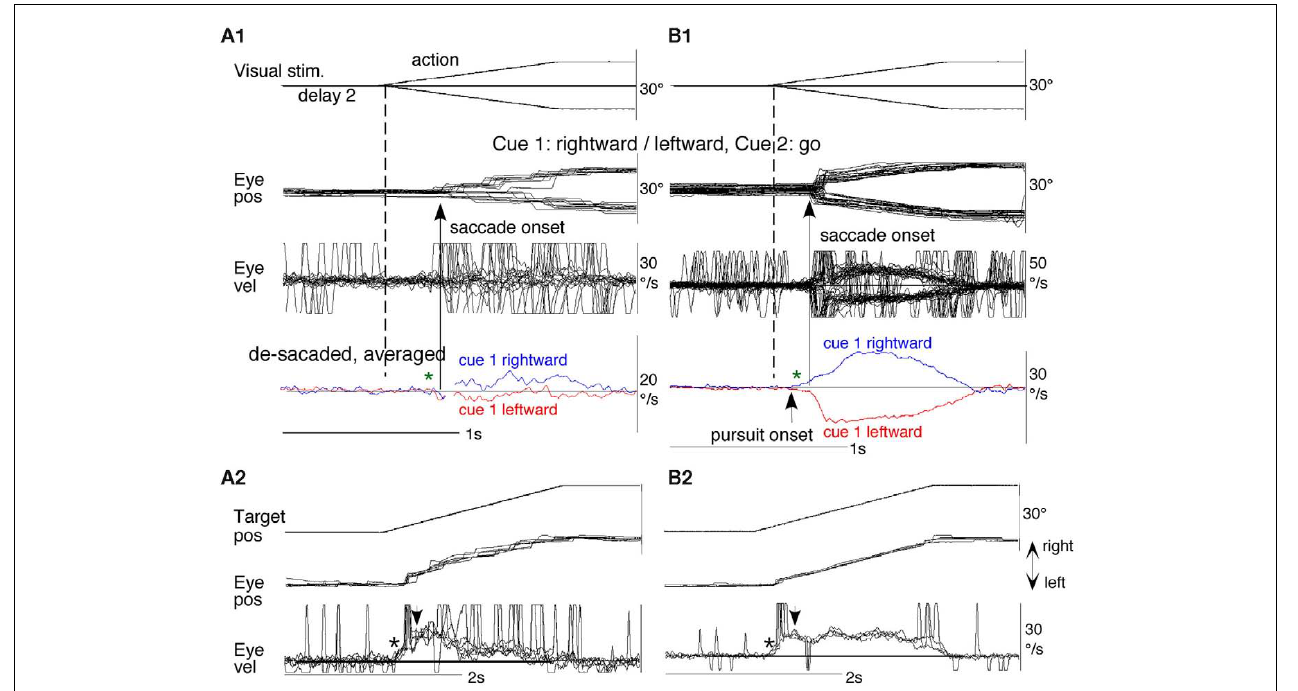
leftward cue 1 motion were combined. Eye velocity during saccades was clipped. Bottom traces in (A1,B1) are de-saccaded, averaged eye velocity for cue 1 rightward and cue 1 leftward as indicated by colors. Modified from Fukushima et al. (2011b) with